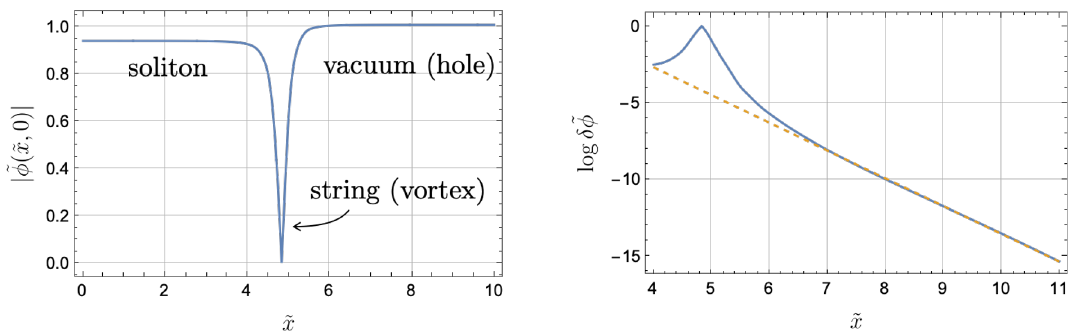
Figure 8 . The left panel shows ˜ φ (˜ x, 0) for the configuration shown in the top-left panel of figure 2, and the right panel shows asymptotic behavior of the same